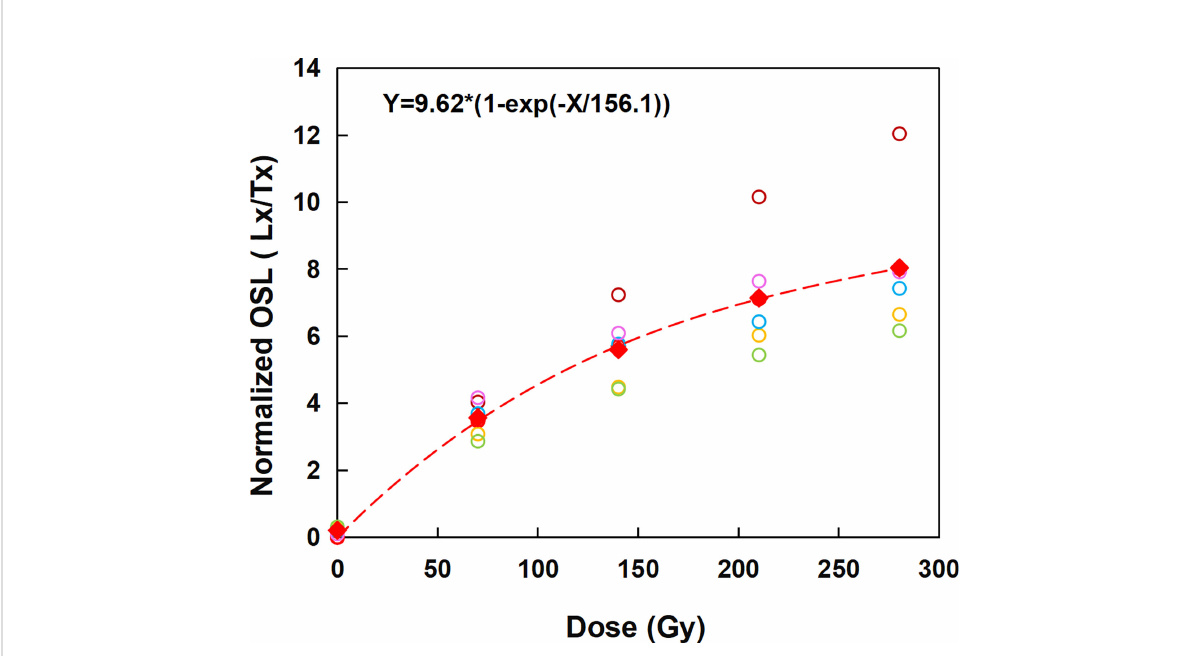
FIGURE 5 Growth curves of fi ve aliquots up to 280 Gy for sample ZK002-G02. The dotted line denotes the average growth curve of the fi ve